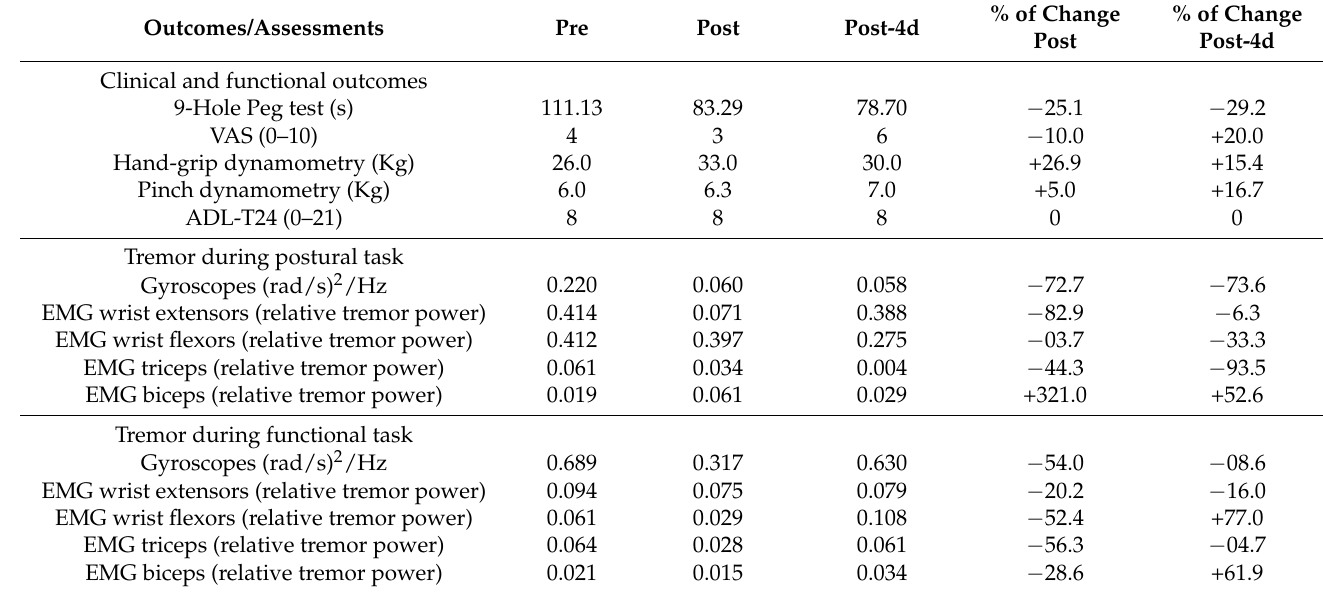
Table 1. Clinical, functional, biomechanical and neurophysiological outcomes. Percentage of change post-intervention (post) and 4 days later (post-4d) compared to the basal state (pre). Outcomes/Assessments Pre Clinical and functional